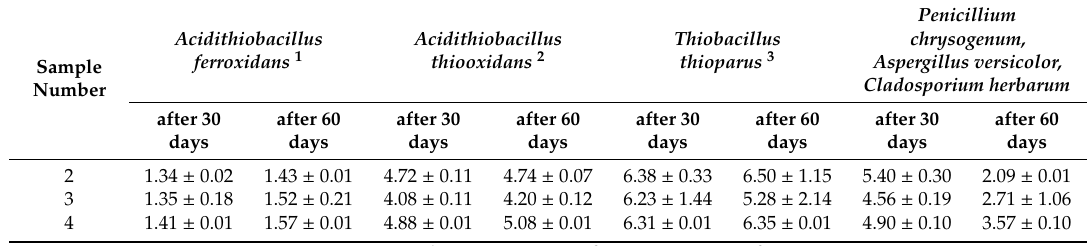
Table 9. The pH of media with sulfur-concrete samples after incubation with microorganisms.